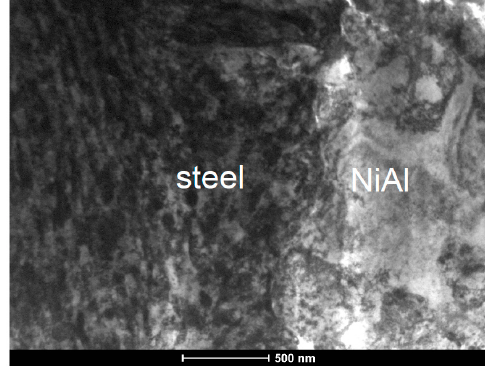
Figure 9. TEM image of the NiAl + CrB 2 coating deposited on steel substrate after 32 h, presenting the substrate/coating interface.